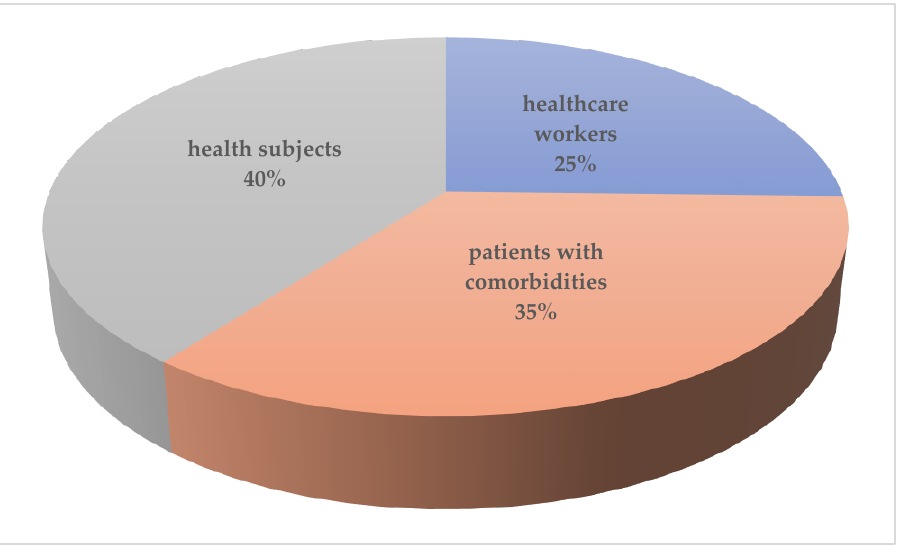
Figure 5. In total, 60% of reinfection involved patients in risk groups. The evolution of the reinfection episode itself was more severe in 92/260 (35.3%) cases with the death only in 14/260 cases (5.3%), 7/260 male (2.65%) and 7/260 females (2.65%);